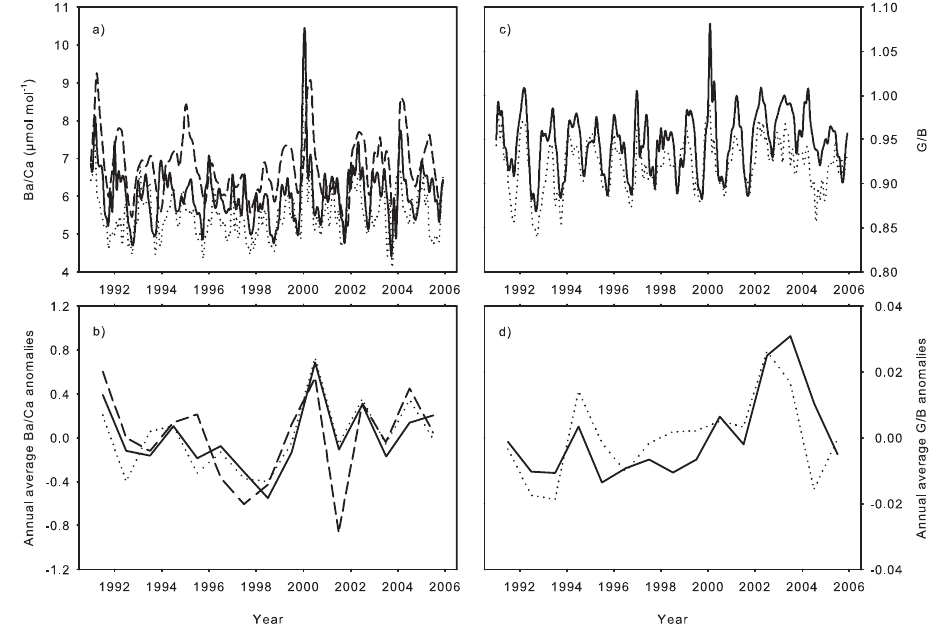
Fig. 3. The three monthly Ba/Ca (left) profiles and two G/B (right) profiles between January 1991 and December 2005, signifying proxy reproducibility in both seasonality and interannual variability. The three Ba/Ca profiles ( a and b ) include LA- MAS1 (solid), LA- MAS3 (dotted) and solution ICP-MS MAS1 (dashed). The two G/B profiles ( c and d ) include MAS1 (solid) and MAS3 (dotted). Absolute values are shown for Ba/Ca and G/B in the upper plots ( a and c , respectively), and annual anomalies for both Ba/Ca and G/B are shown in the lower plots ( b and d ,